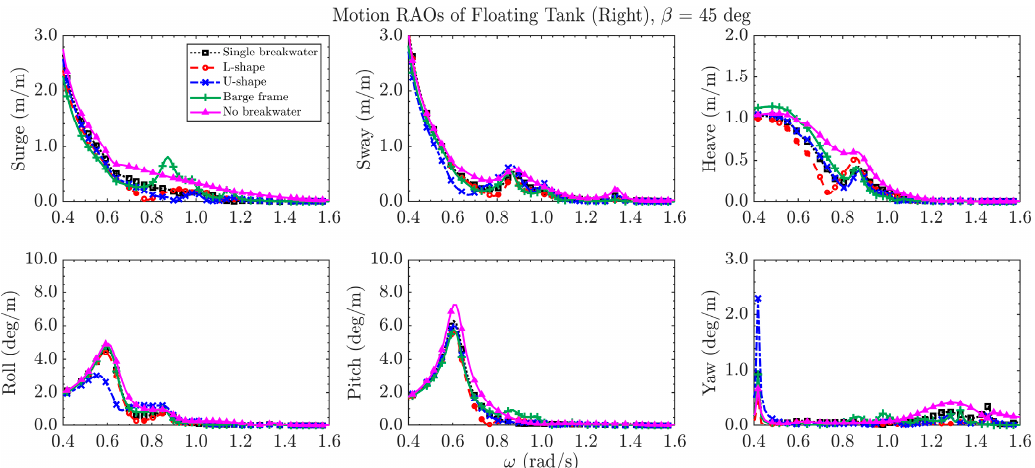
Figure 13. Motion RAOs of the right-hand-side floating tank with the different configurations of floating breakwaters in 45 deg incident wave direction.